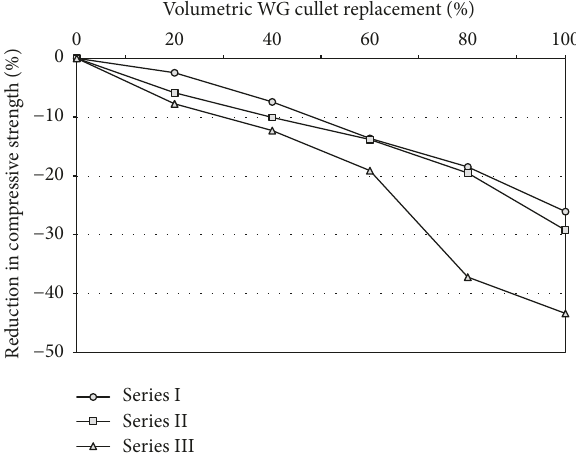
Figure 3: Compressive strength of SCC mixtures at 28 days with respect to WG cullet content.